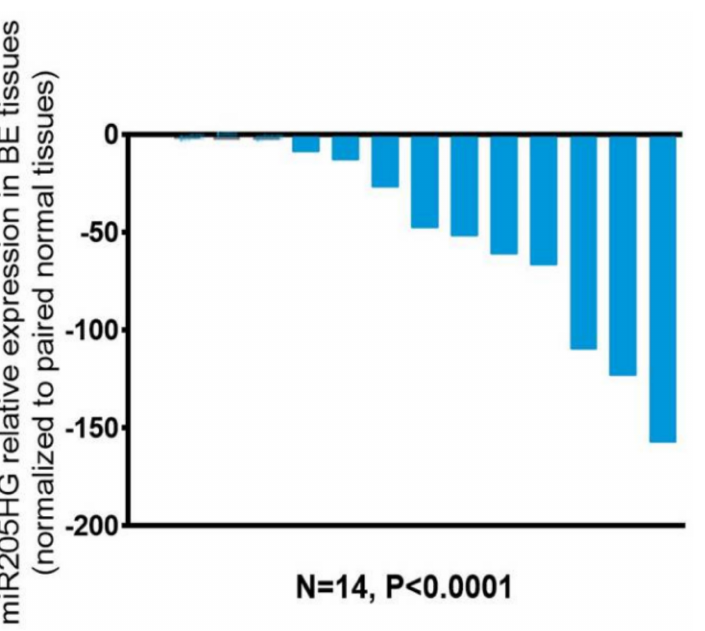
Figure 5. miR205HG expression in NE-BE tissue pairs. Fourteen matched NE-BE tissue pairs were assessed for miR205HG expression by qRT-PCR. miR205HG was downregulated relative to NE in all BE tissues studied (14/14, average fold-change 48.3, paired t-test p -value <